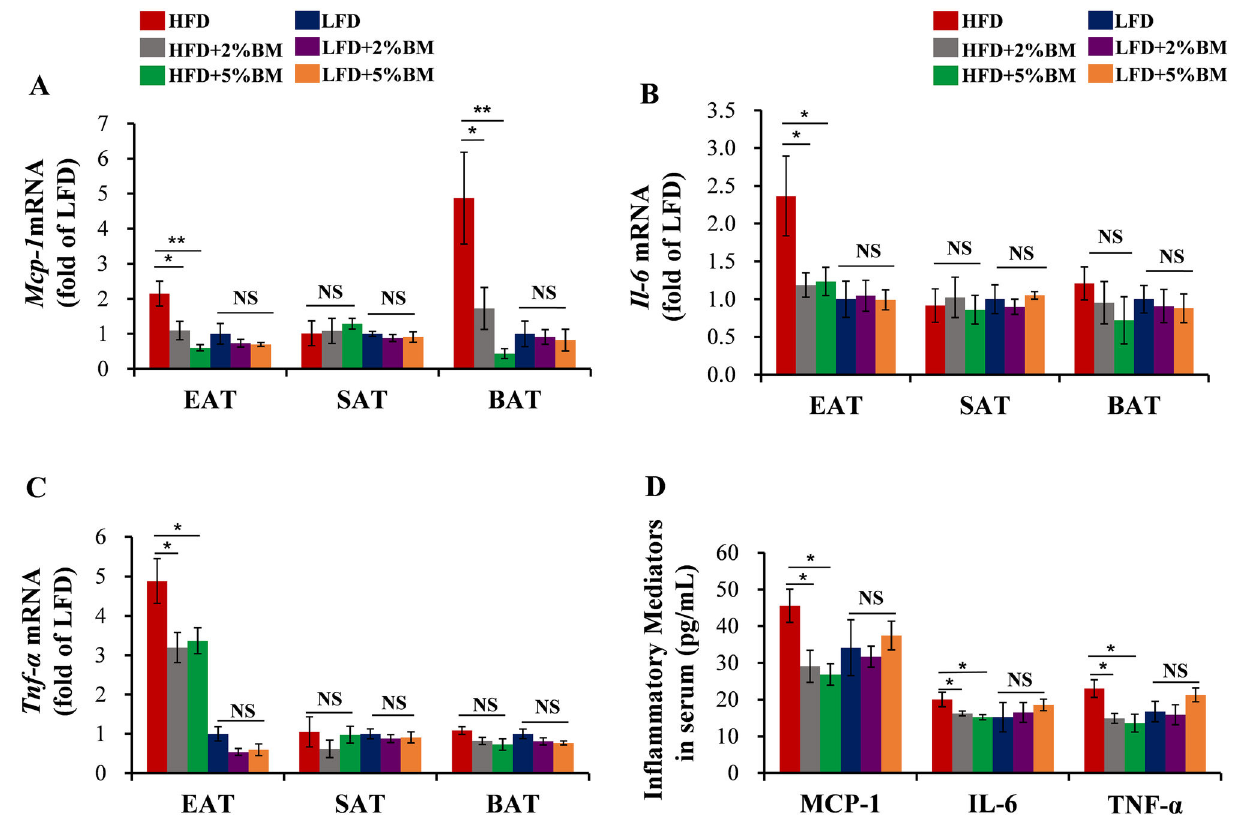
Figure 7. BM down-regulated inflammation mediator levels in adipose tissues and serum of mice. The mRNA expression of Mcp-1 (A) , Il-6 (B) and Tnf-α (C) in EAT, SAT and BAT of mice. (D) The inflammation mediator concentrations in serum were measured by mouse MCP-1, IL-6 and TNF-α ELISA kit of mice. Statistical difference between groups is shown using a nonparametric Mann-Whitney test. n=8 per group. * P <0.05, ** P <0.01. All data in (A)-(D) are means ± SEM. doi: